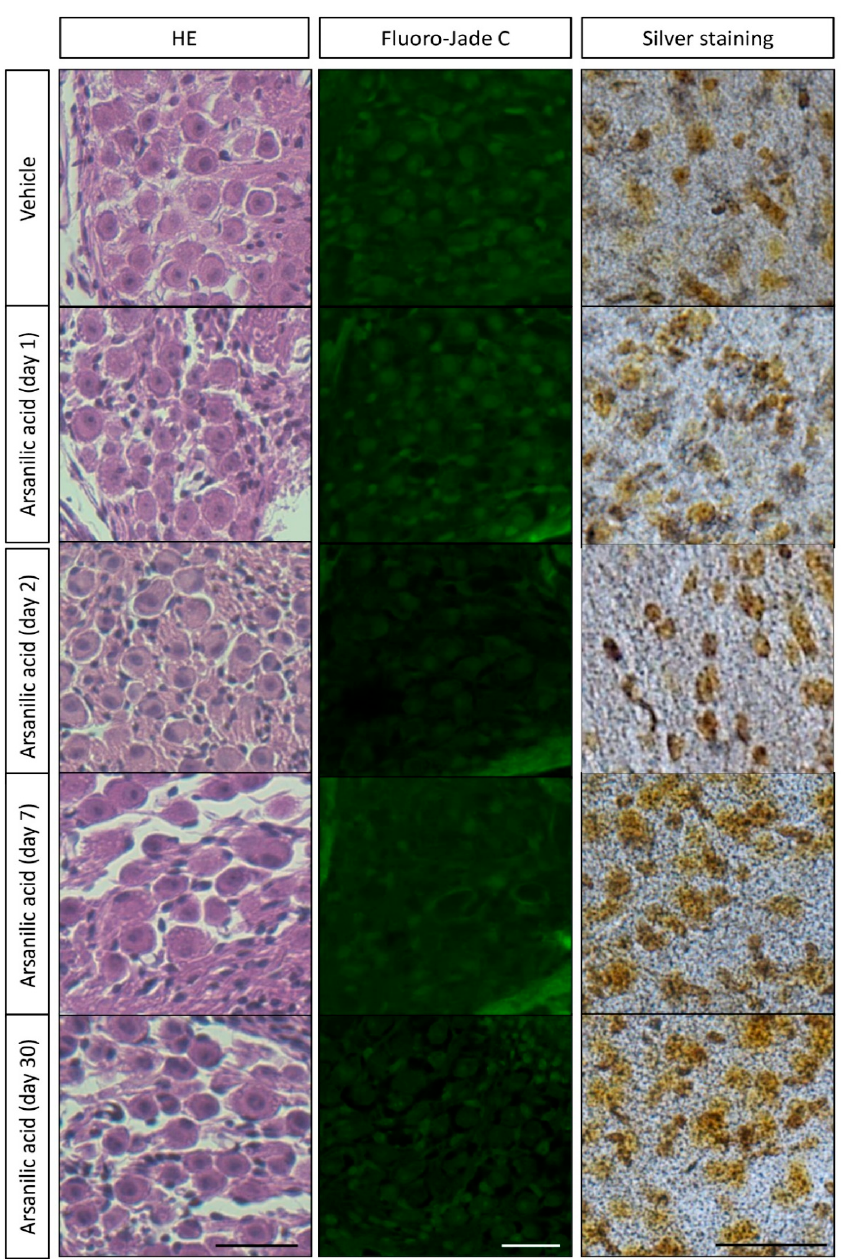
Figure 3. Observation of cells in mouse vestibular ganglions after staining with hematoxylin–eosin, Fluoro-Jade C, and silver. Paraffin sections of temporal bone were stained with hematoxylin–eosin (HE) and Fluoro-Jade C to check cellular integrity and degeneration. We further employed an amino-cupric silver staining method that is very sensitive in detection of cellular degeneration. For the silver staining, we used both frozen sections and vibratome sections of the vestibular ganglions. Because the frozen sections were of uniform thickness and gave us clearer images, representative pictures of frozen sections are shown here. There is no difference in the amount of structural damage observed with hematoxylin–eosin staining, or in the number of cells stained by Fluoro-Jade C and silver, between the arsanilic acid (unilateral labyrinthectomy with arsanilic acid) and vehicle (unilateral labyrinthectomy with phosphate buffer) groups. Scale bar, 20 µm.